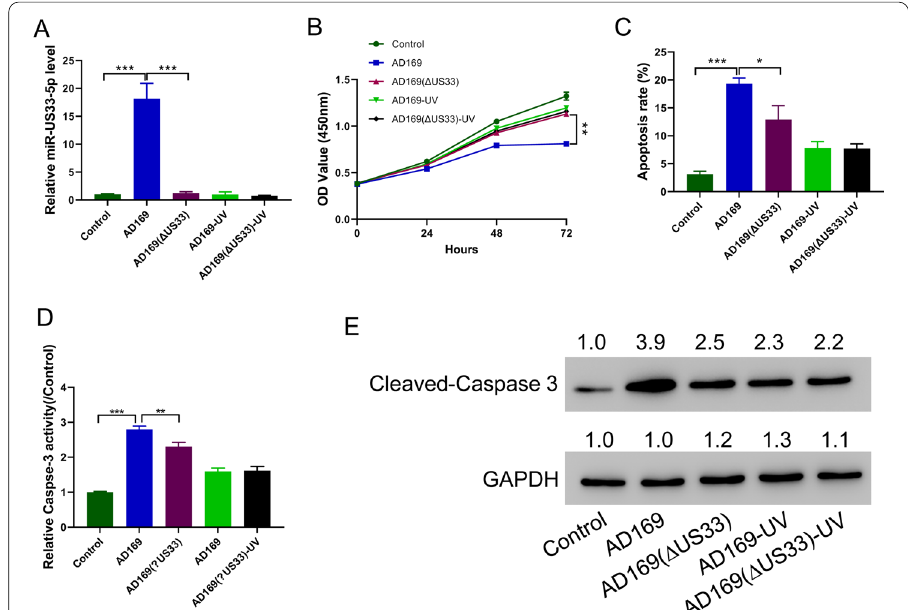
Fig. 1 HCMV promotes apoptosis by upregulating HCMV-miR-US33-5p. A qRT-PCR analysis of HCMV-miR-US33-5p expression level in HA-VSMCs infected with different viruses. B CCK-8 assay showed that HCMV AD169 virus infection inhibited HA-VSMC proliferation, while ultraviolet inactivation of the virus (UV) or the AD169 (ΔUS33) virus showed a greatly reduced inhibitory effect on HA-VSMC proliferation. C – E Flow cytometry assay ( C ), caspase-3 activity assay ( D ), and Western blot analysis of cleaved caspase-3 ( E ) indicated that HCMV AD169 virus infection promoted HA-VSMC apoptosis, while UV-inactivated virus (UV) or AD169 (ΔUS33) virus showed a greatly reduced stimulatory effect on HA-VSMC apoptosis. Western blot was performed three times; representative images are presented. Numbers above lanes indicate the relative protein level, normalized relative to control samples. * P < 0.05, ** P < 0.01, *** P < 0.001 ( n